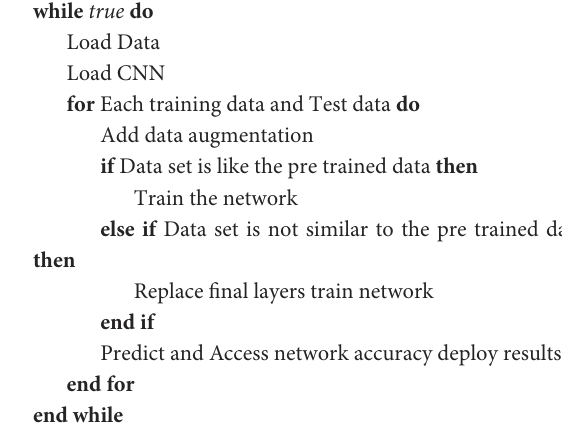
Algorithm 1. Prepossessing and training